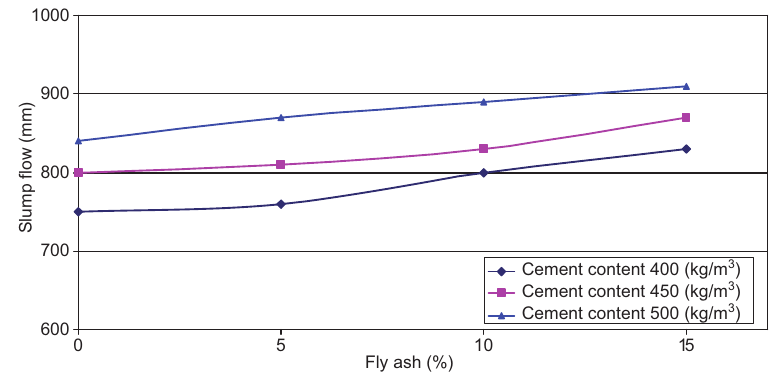
Figure 5 Slump flow diameter changes for different mixes of HPSCC.